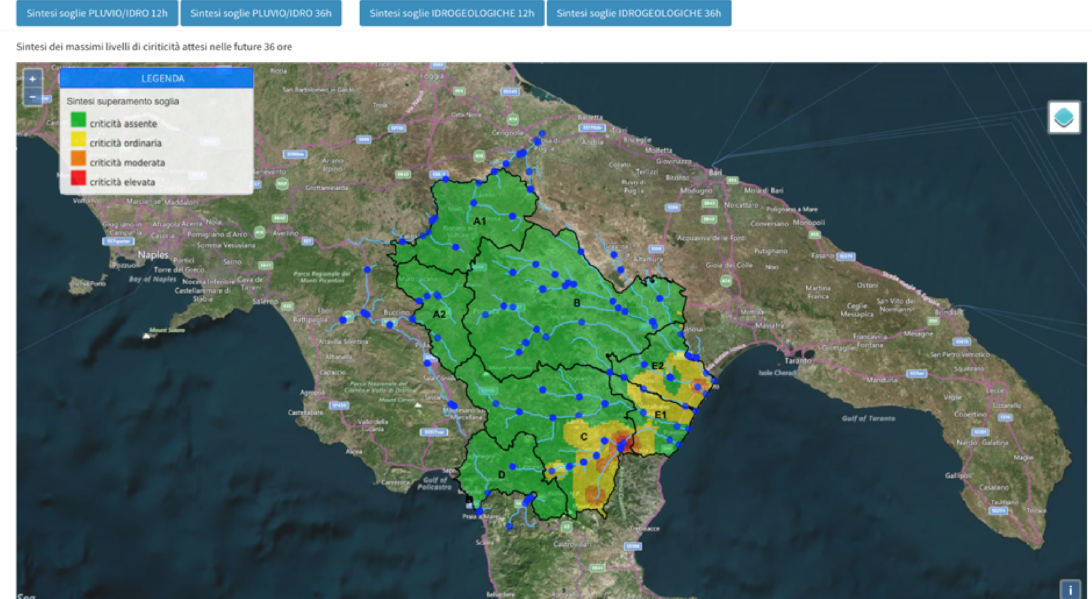
Figure A1. Example of a dynamic layer extracted from the Web-GIS. The real-time map shows the alert levels for the 36-h forecasts: green areas on the map indicate no criticality, while red represents the highest